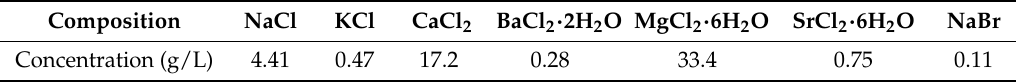
Table 2. Chemical composition of the formation water extracted from the gas condensate